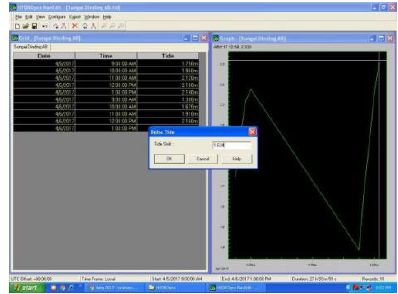
Figure 2. The Tide Grid and Tide Graph display